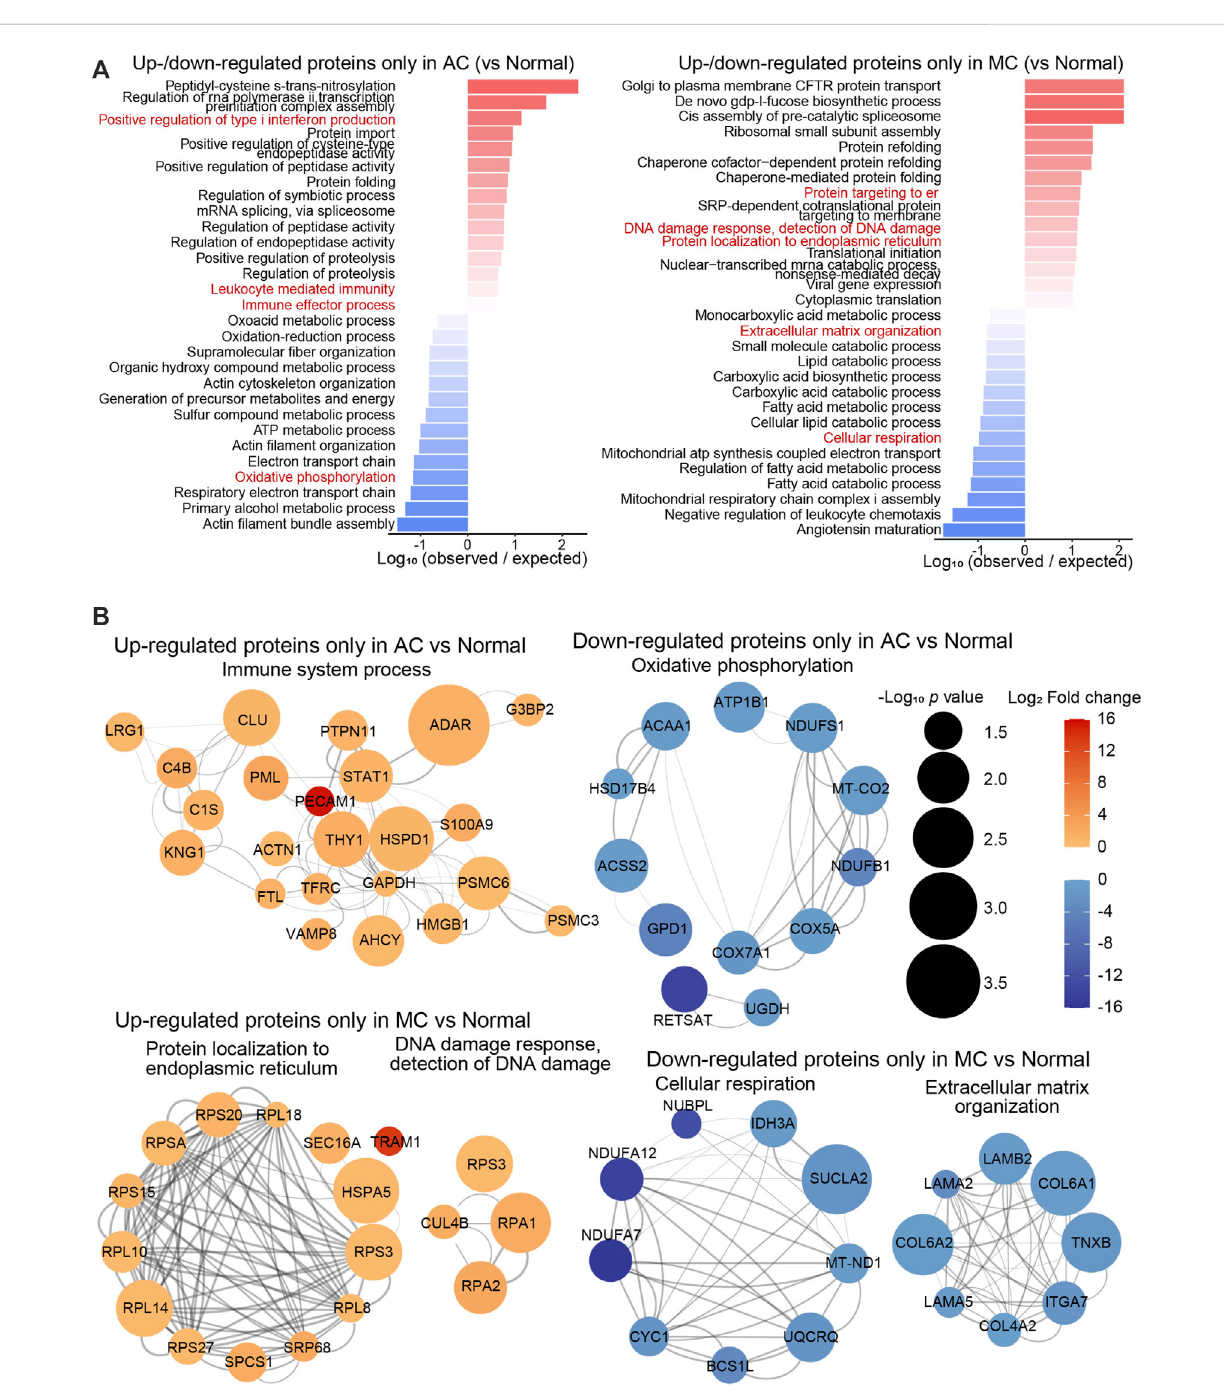
Proteomics difference between two types of colorectal adenocarcinomas and normal colon. (A) Bar plots showed the top 15 biological processes enriched with up- or downregulated differentially expressed proteins only in AC (left) or in MC (right). (B) Networks presented proteins of partial representative biological processes. Color bar: -log 10 (protein expression p -value of AC/normal or MC/normal). Circle size: -log 10 (protein expression fold change of AC/normal or